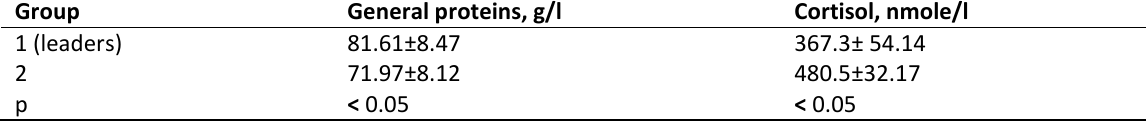
Table 3. Content of general proteins and level of cortisol in blood of both groups’ ski racers (М±m) Group General proteins, g/l Cortisol,